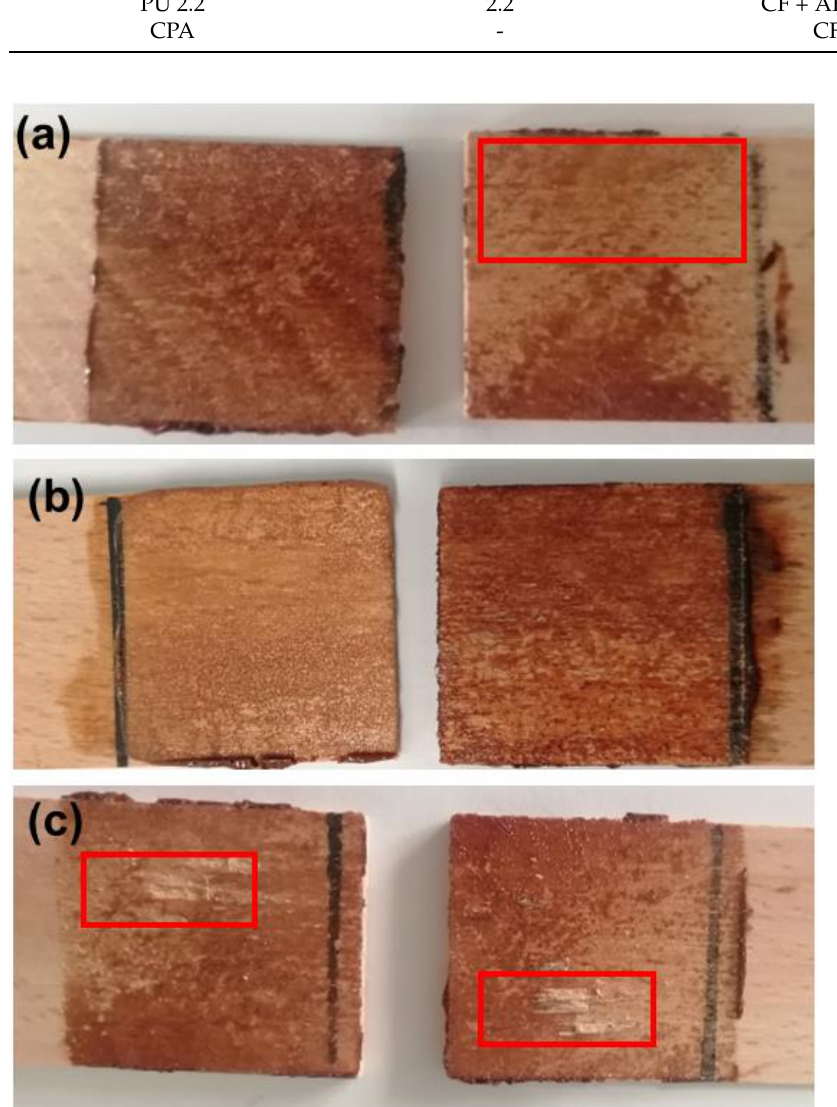
Figure 4. Examples of ( a ) adhesive failure (AF), ( b ) cohesive failure (CF), and ( c ) substrate failure (SF).